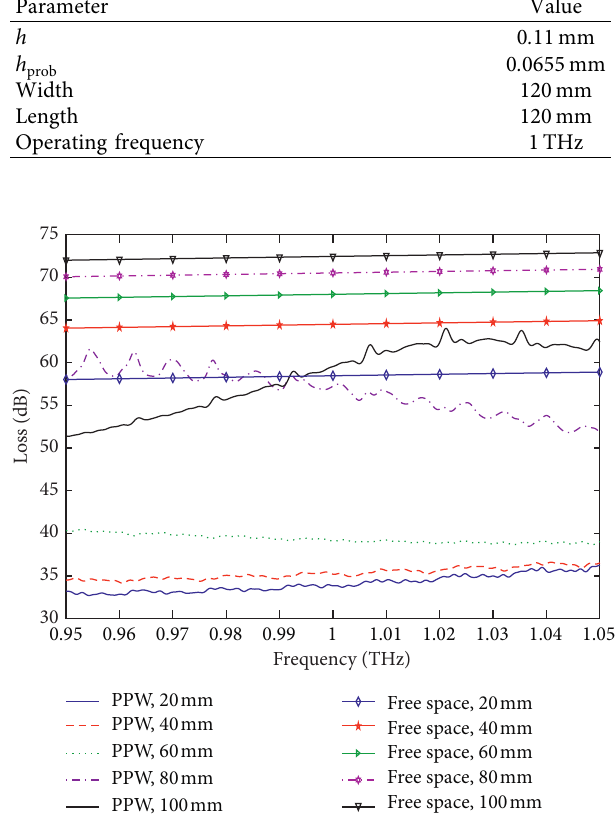
Figure 9: The insertion losses of guided-waves in PPW for different distances between gateway antennas in comparison with the free space losses for the same distances.